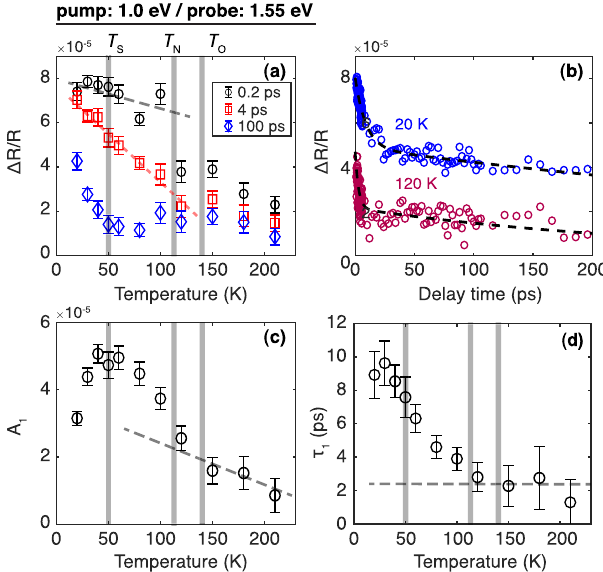
Fig. 3 Analysis of the temperature-dependent re fl ectivity transients ( Δ R / R ) after 1.0 eV photoexcitation. a Δ R / R at time delays of 0.2 ps (black circles), 4 ps (red squares), and 100 ps (blue diamonds). b Transient re fl ectivity data at temperature T = 20 K (blue circles) and 120 K (purple circles) along with fi ts using bi-exponential decay functions (dashed lines). The temperature dependence of the ( c ) amplitude A 1 and ( d ) decay time τ 1 of the fast component extracted from our fi ts. The solid grey lines indicate the transition temperatures of the stripe-type order ( T S ), antiferro-type spin order ( T N ), and antiferro-type orbital order ( T O ), respectively. The error bars were calculated as described in